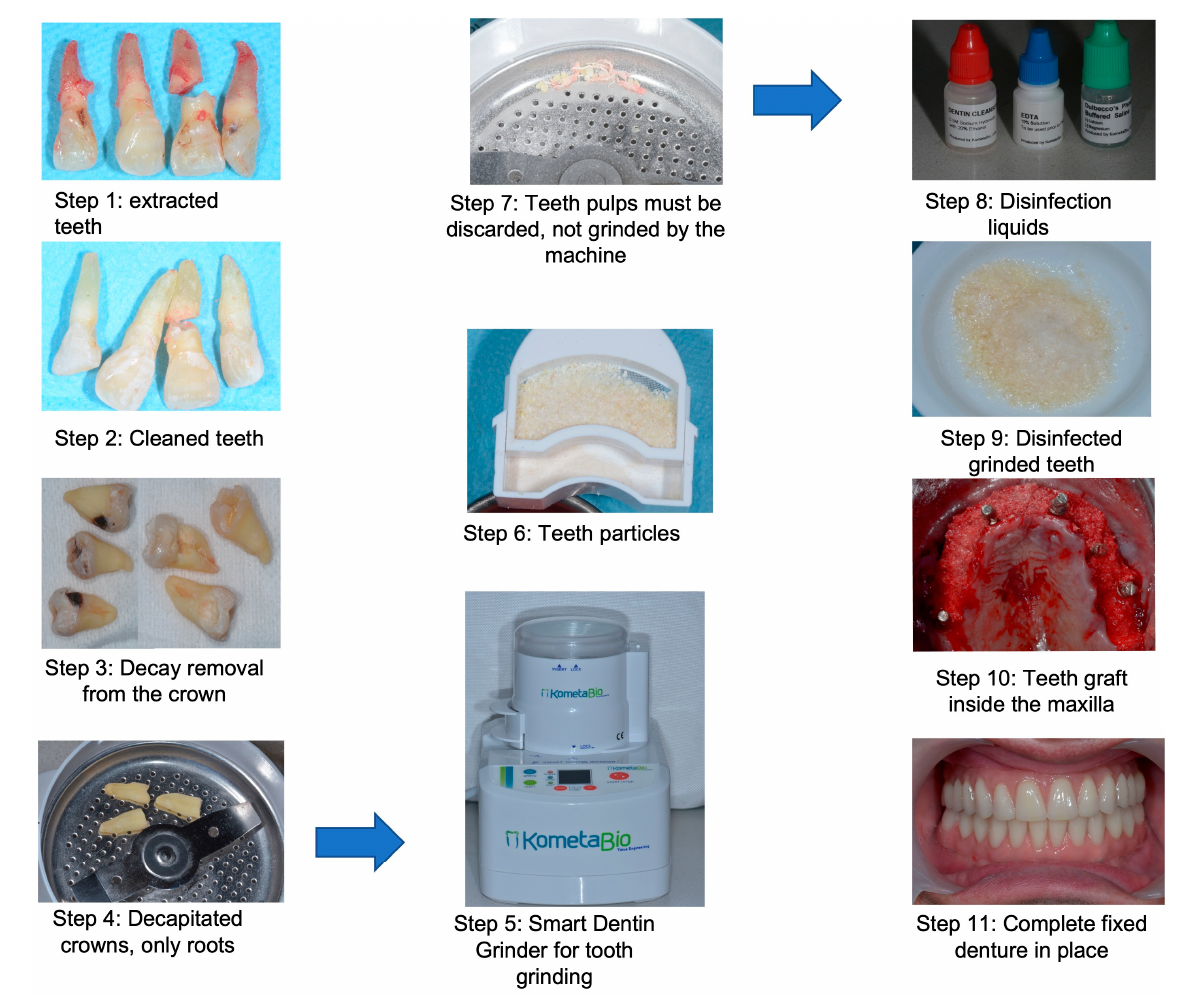
Medicina 2022 , 58 , x FOR PEER REVIEW Diagram 1. Teeth grinding procedure. Chart 1. Teeth grinding procedure.